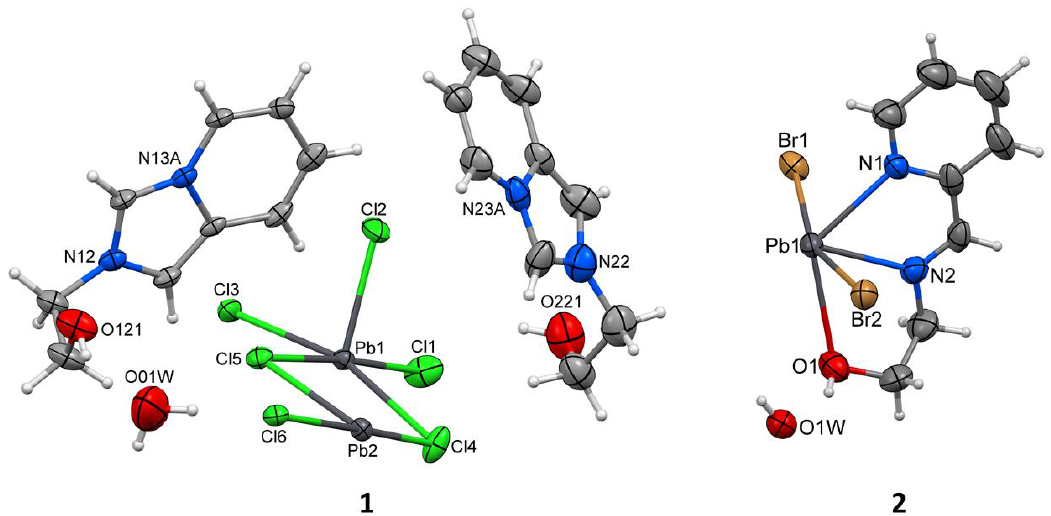
Figure 1. Asymmetric units and principal atom labelling for [L1] 2n [Pb 2 Cl 6 ] n ∞ · nH 2 O ( 1 ) and [PbBr 2 (L2)] n ∞ · 0.5nH 2 O ( 2 ) with the 50% probability ellipsoids. The major component of the disor- dered (N22, N23A) cation of 1 is shown.